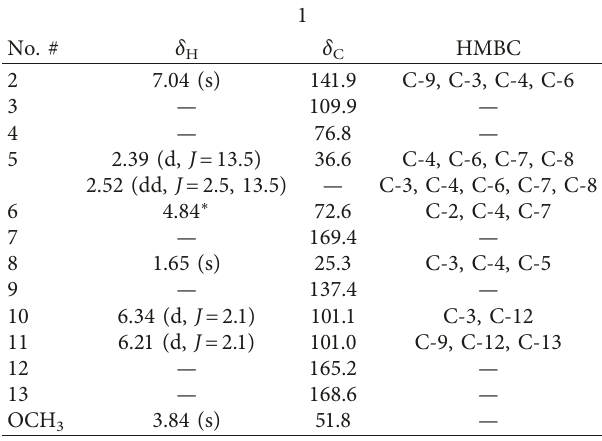
Table 1: 1 H, 13 C NMR, and HMBC spectroscopic data of com- pound 1 (CD 3